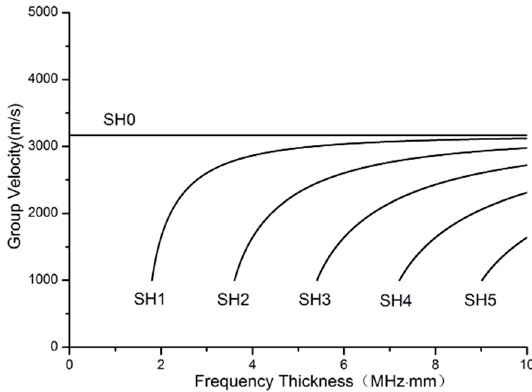
Figure 2. SH mode group velocity dispersion curves for the stainless steel layer.